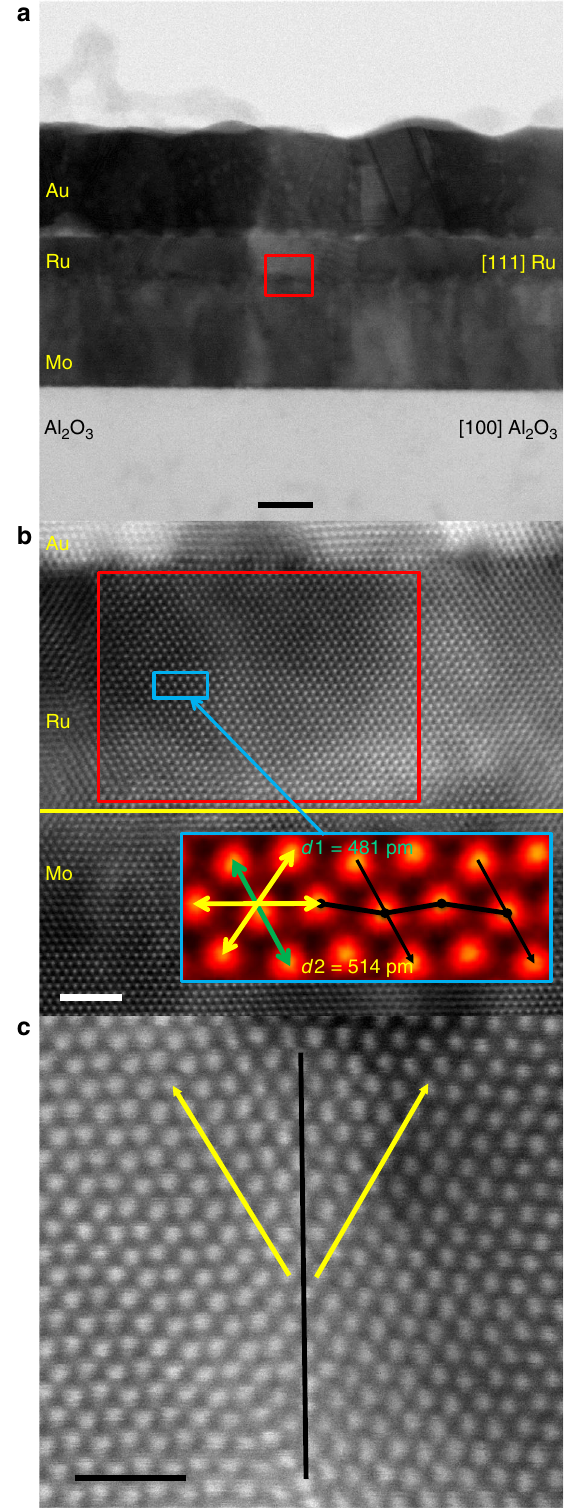
Fig. 2 Characterization of Ru tetragonal structure. Cross-section STEM images along the [001] zone axis of Al 2 O 3 . a The annular bright fi eld (ABF) STEM images of the full sample stack. Scale bar is 10nm. b High-angle annular dark fi eld (HAADF) STEM at the Mo – Ru interface, with the inset showing the high-precision HADDF STEM for the [111] Ru zone axis using the non-rigid registration method 15 . The lattice distortion is shown using the dashed black line. Scale bar is 2nm. c A HAAADF STEM zoom in on a Ru grain boundary due to equivalent surfaces growth surfaces. Scale bar is 1